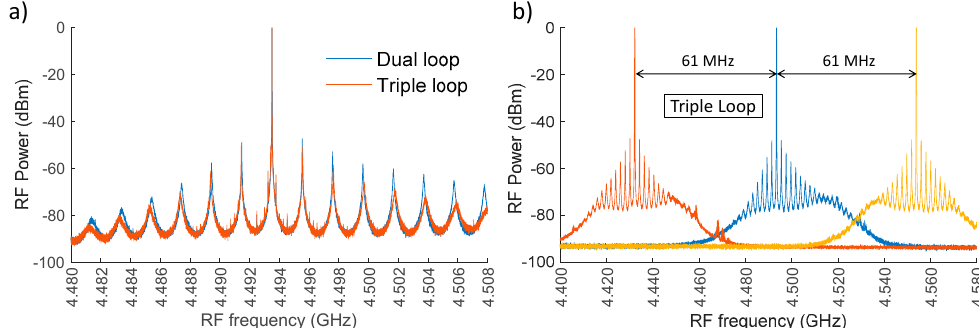
Figure 9. Experimental oscillation spectra of a multi-cavity Vernier optoelectronic oscillator using a 20-m seven-core fiber for: ( a ) dual-versus triple-loop operation; and ( b ) three consecutive oscillation modes for the triple-loop operation [59].